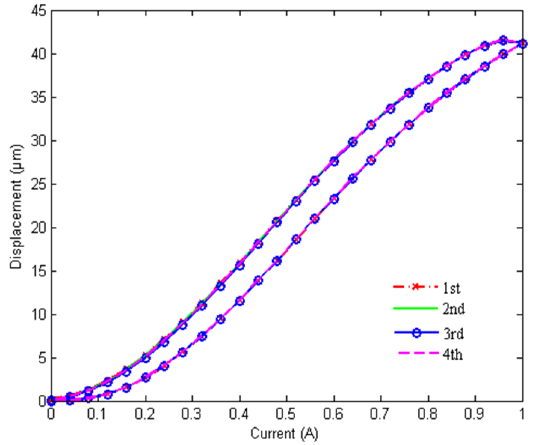
Figure 6. Four simulation results of the DE.